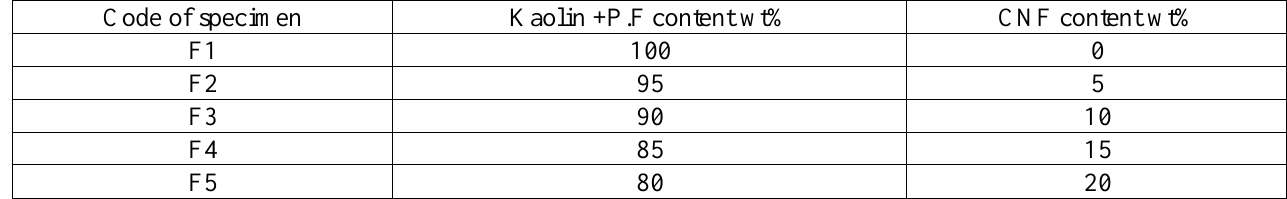
Figure 1: Photograph of prepared specimens after sintering Table 2: Weight ratios of prepared magnetic dispersion porous ceramic